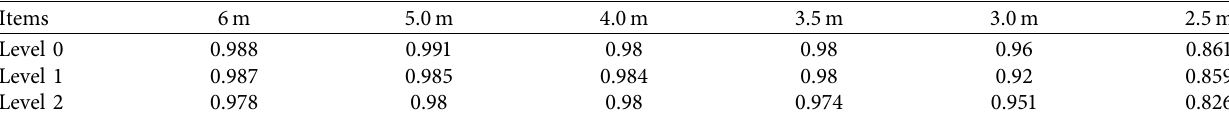
Table 11: Test results of actual beam bridge (side).